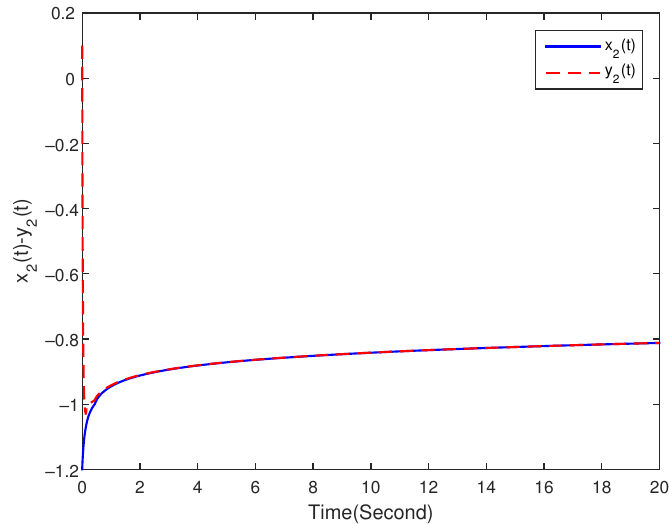
Figure 2. Trajectories of x 2 ( t ) and y 2 ( t ) with control.